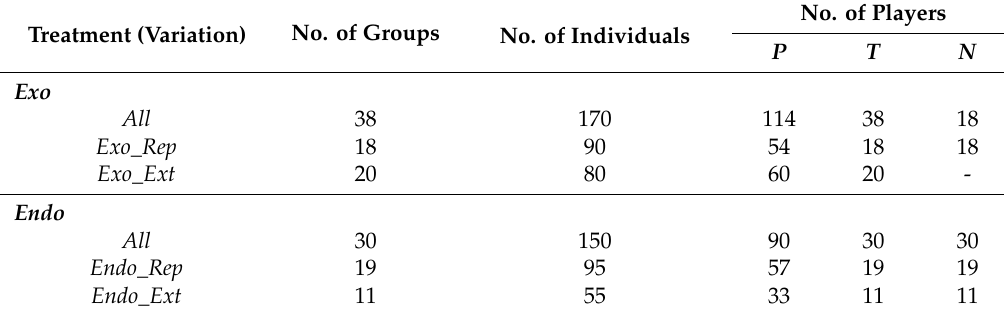
Table 1. Allocation of subjects to